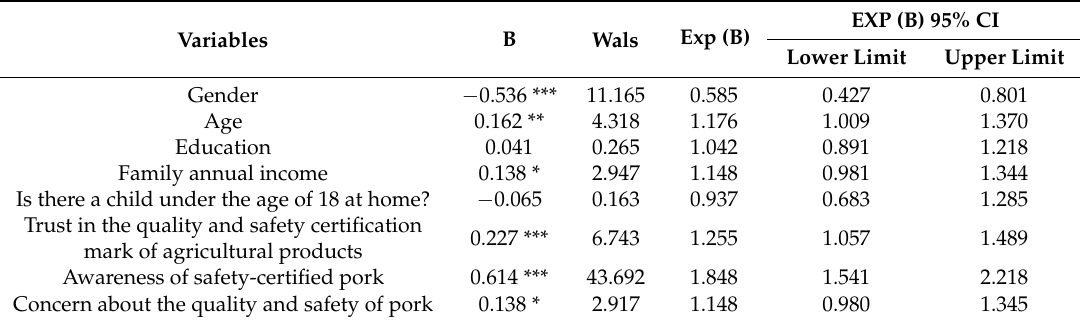
The Binary Logit regression model estimation results for consumers